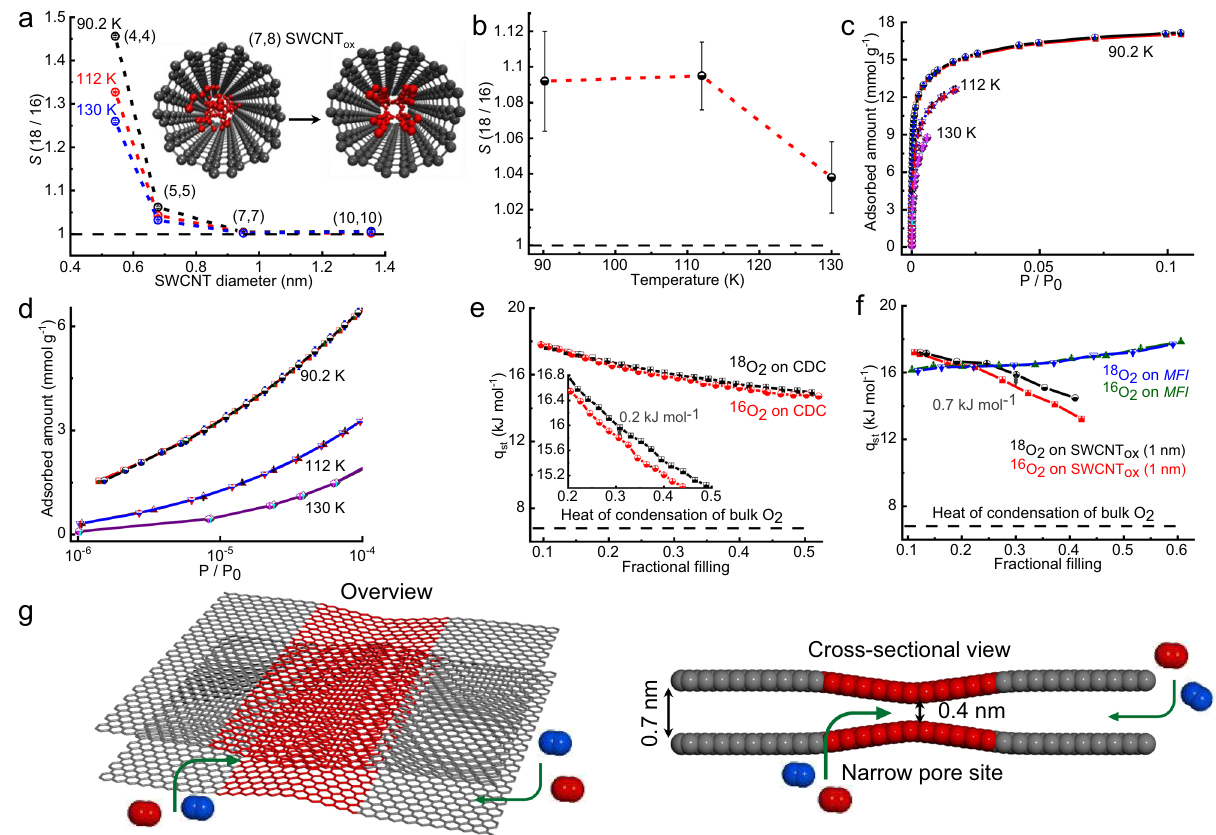
Fig. 5 Theoretical selectivity and energetics of oxygen isotope adsorption. a Dependence of the value of S on the diameter of SWCNT ox and temperatures for the zero-loading conditions (one molecule of oxygen per cell). The temperatures considered were 90.2, 112, and 130 K. The inset shows a schematic illustration of the (7,8) SWCNT ox with adsorbed oxygen molecules. (Left) The initial con fi guration showing a random packing con fi guration of molecular oxygen. (Right) A transition to an ordered molecular packing of oxygen molecules after geometry optimization using force- fi eld methods. b Selectivity S for zeolite MFI with the temperature at P / P 0 = 0.12. Error bars are standard deviations calculated from four measurements. c 18 O 2 and 16 O 2 adsorption isotherms of carbide-derived carbon (CDC) at 90.2, 112, and 130 K. d Semilogarithmic plots of the isotherms in the low relative pressure region. e Isosteric heats of adsorption ( q st ) of the O 2 isotopes on CDC as a function of fractional fi lling. Here, 16 O 2 uptake is normalized to the maximum uptake at 90.2 K to obtain the fractional fi lling. f Isosteric heats of adsorption plotted versus fractional fi lling for SWCNT ox (1 nm) and MFI. Error bars are the standard deviations calculated fom three measurements. g Representative model showing the presence of narrow pore sites along with the 2D open entrances for oxygen isotopes ( 16 O 2 is red and 18 O 2 is blue) in fractional fi lling due to the changes to the adsorption sites of the shallower interaction potential wells. To evaluate the contribution of the narrowest pore sites toward the total adsorption, we simulated N 2 adsorption on our CDC model as shown in Fig. 2e left. The geometrical cumulative pore volume using nitrogen as a probe atom was calculated using Poreblazer 40 . It is noted that the pore highlighted within the small cyan circle contains spheres of diameter <0.4 nm and that space is not accessible to nitrogen (Supplementary Fig. 25). The cumulative pore volume of such narrow spaces is V narrow-pore ( d < 0.4 nm) = 0.021 cm 3 g − 1 ,